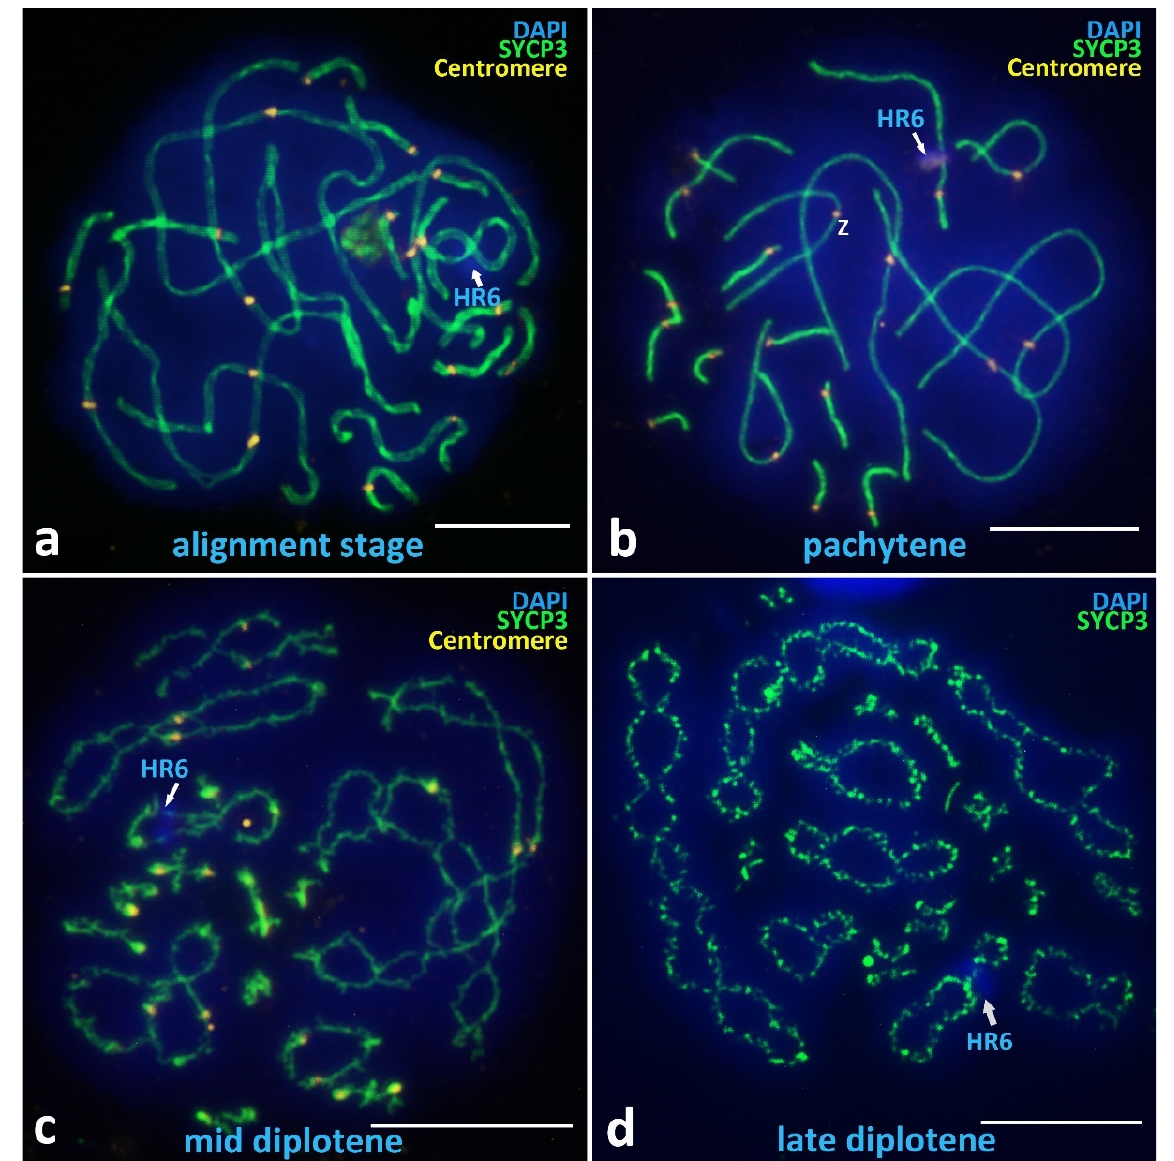
Figure 4. Alignment stage and postsynaptic stages in V. berus primary spermatocytes. ( a ) Alignment stage, spatial alignment of pairs of axial elements of homologous chromosomes located opposite each other. ( b ) Pachytene, complete synapsis of all 18 bivalents. ( c ) Mid diplotene, desynapsis of homologues, chiasmata. ( d ) Late diplotene, diffuse axial elements, unloading of the SYCP3, chiasmata. Heterochromatin region on the chromosome pair 6 is indicated as HR6. Axial elements of chromosomes are immunostained with antibodies against the SYCP3 protein (green), centromeres with antikinetochore antibodies ACA (yellow). Mismatch repair protein sites are immunostained with antibodies against MLH1 protein (red). Chromatin stained with DAPI (blue). Bar—10 μ m.